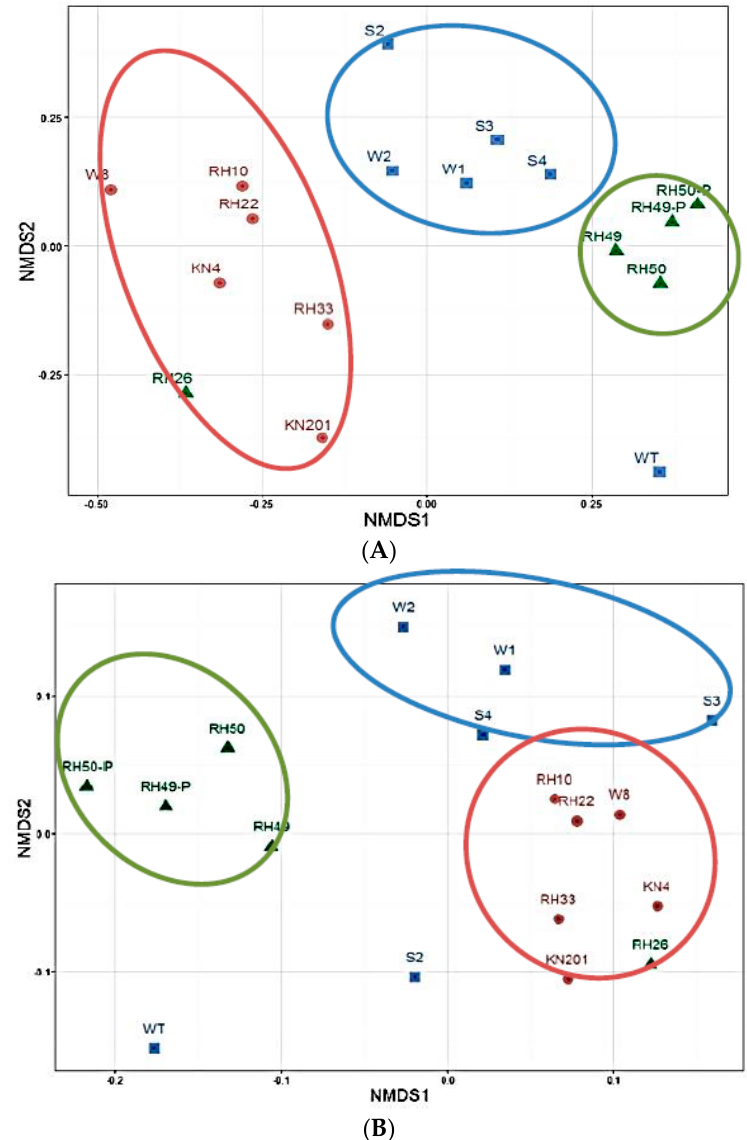
Figure 2. Nonmetric multidimensional scaling (NMDS) ordination for the microbial communities in the examined 17 boreholes using ( A ) the Bray-Curtis distance matrix, and ( B ) the weighted UniFrac distance matrix. Groups are categorized according to borehole location in the industrial area (symbols and colors), green triangles represent the Production plan, blue squares, the Wadi Hovav; red circles indicate Downstream. Circles represent clustered groups according to borehole location in the industrial area. Distance matrix based on 16S rRNA Illumina sequencing. Stress: ( A ) 0.153 ( B ) 0.098.